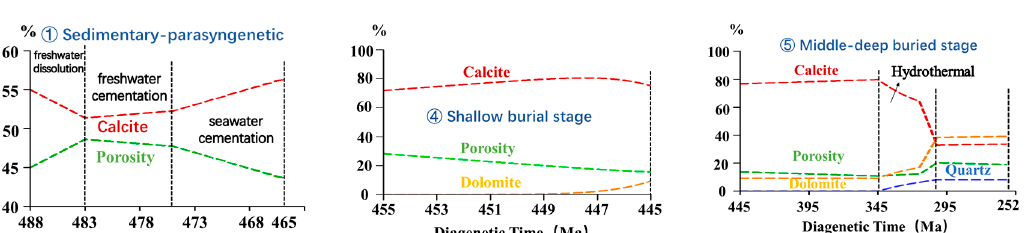
Figure 11. Porosity and typical mineral content evolution under seawater and freshwater interaction environment.